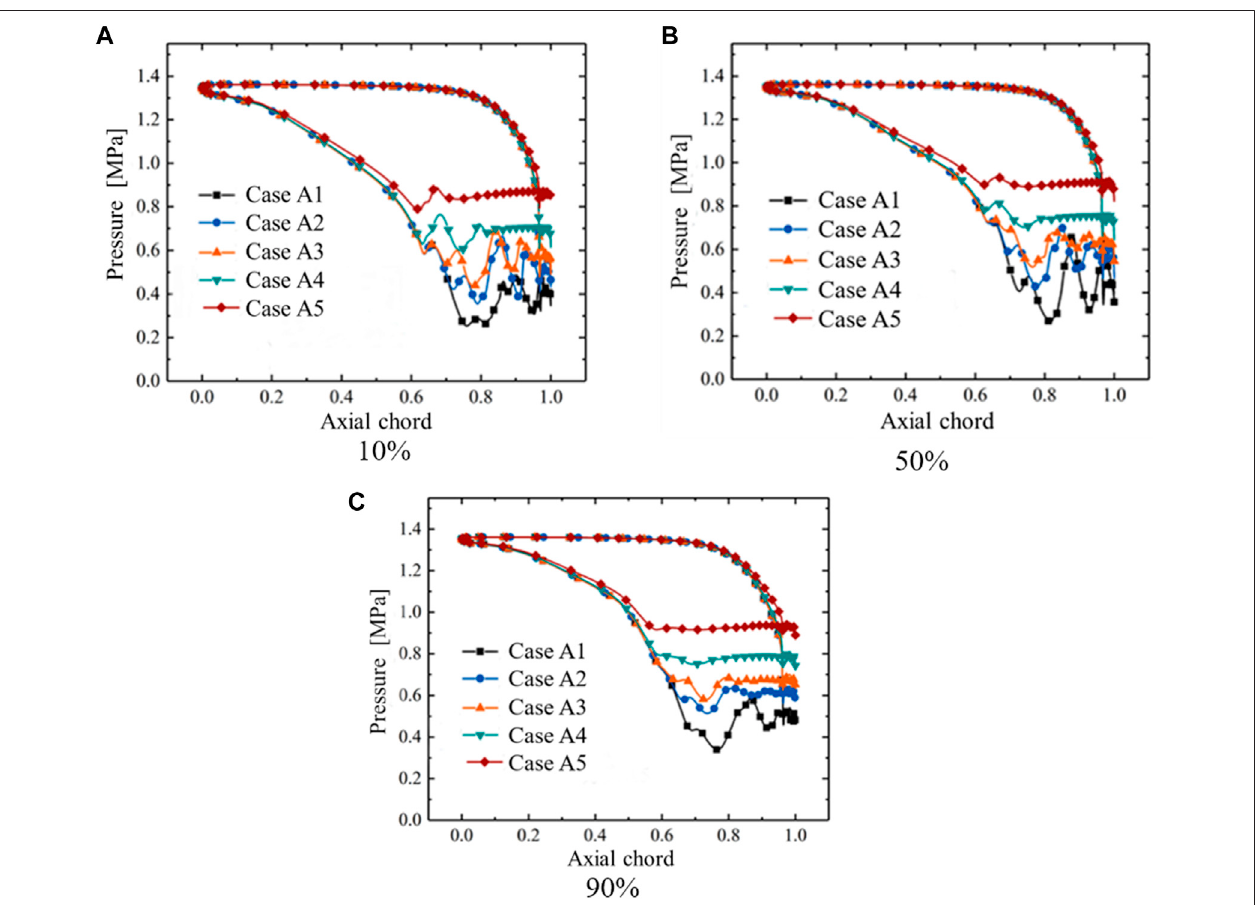
FIGURE 6 | Blade surface pressure distribution of stator from Case A1 to Case A5. (A) 10%. (B) 50%. (C) 90%.